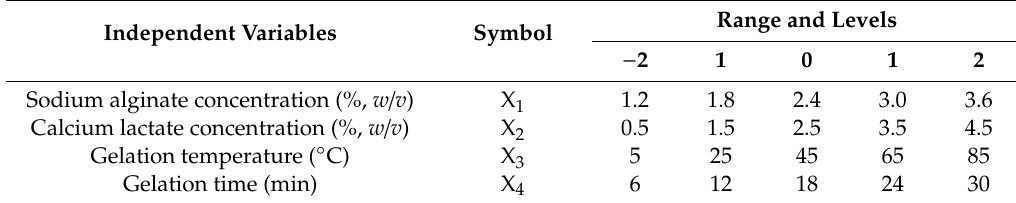
Range and Levels − 2